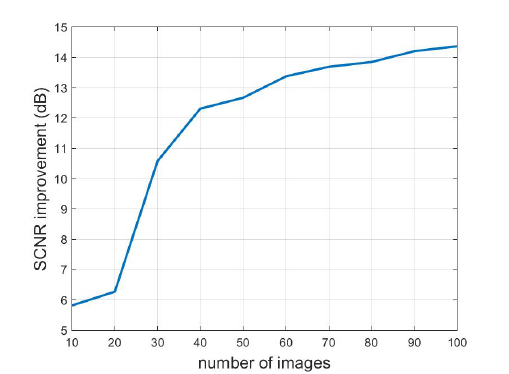
Figure 24. The curve of G SCNR ( n ) versus number of images n